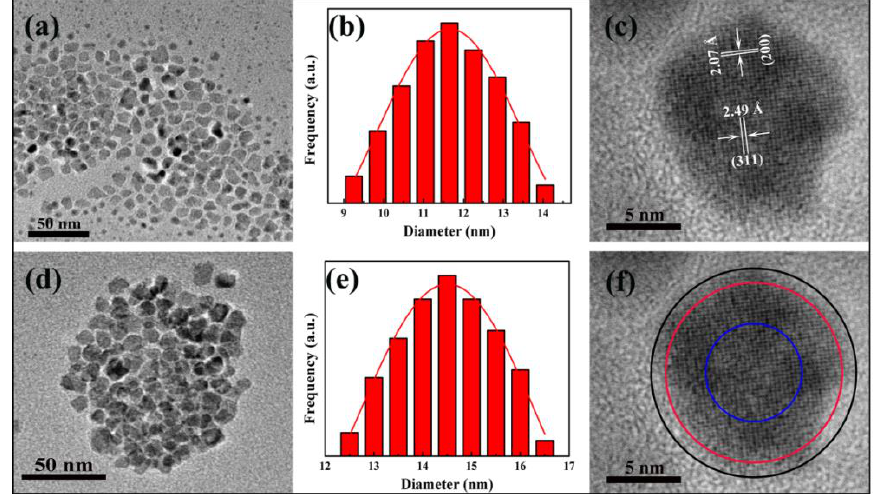
Figure 1. Transmission electron microscopy (TEM) bright-field micrographs of ( a ) Fe 3 O 4